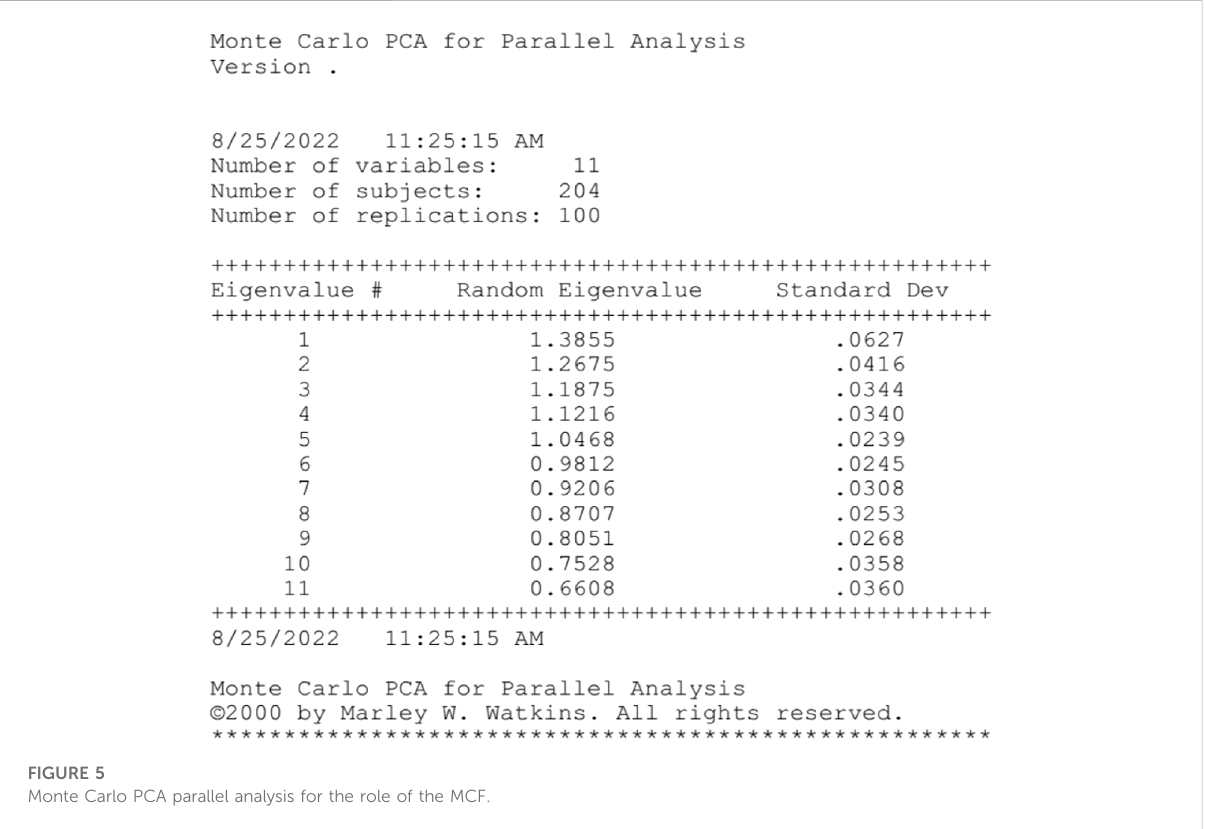
FIGURE 5 Monte Carlo PCA parallel analysis for the role of the MCF.